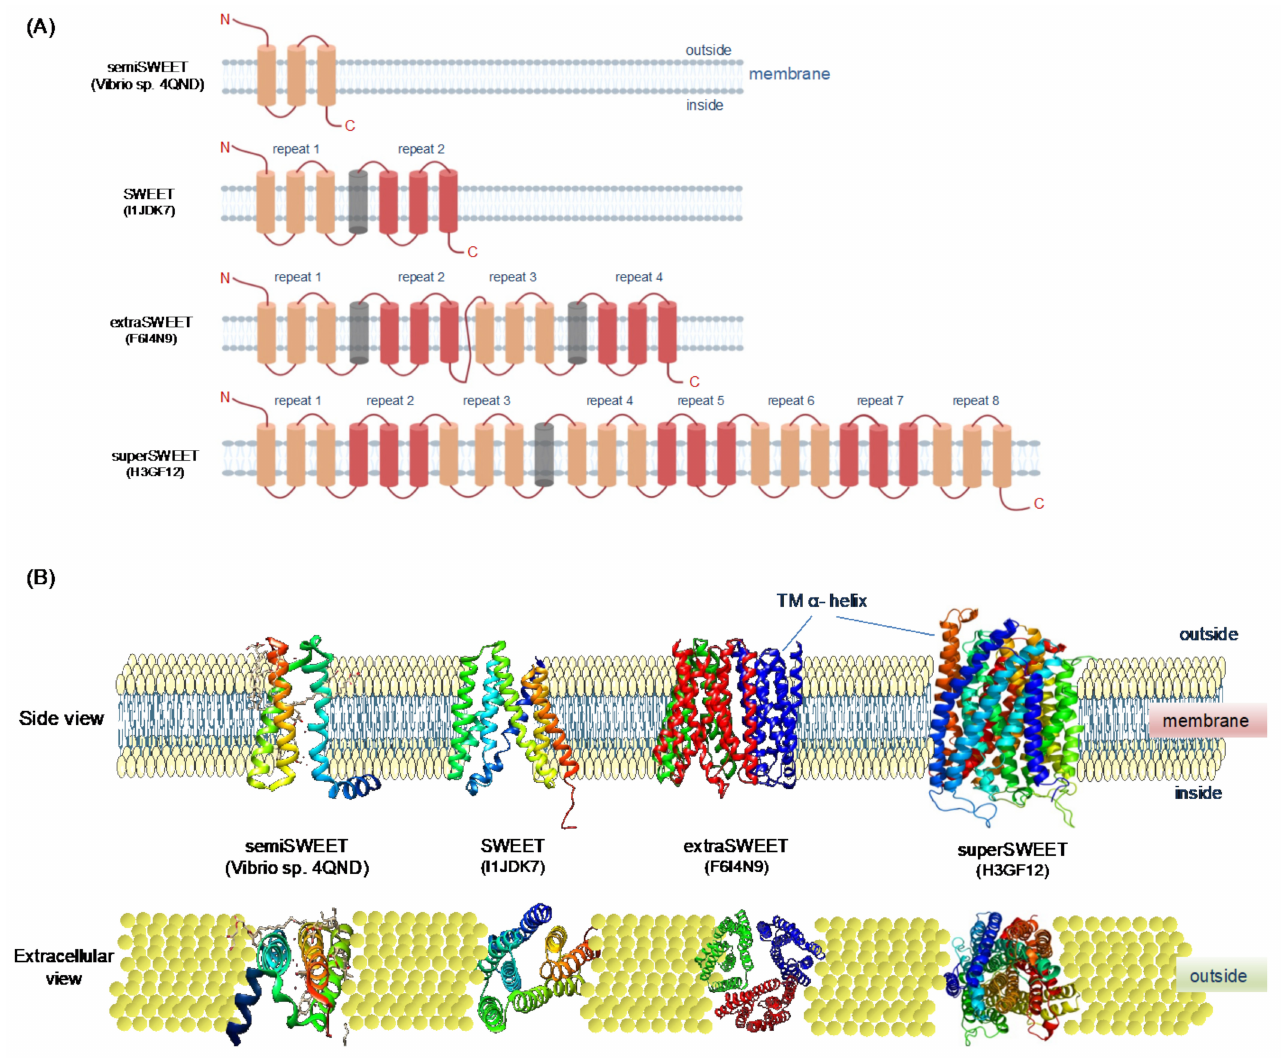
Figure 2. Schematic representation of two-dimensional (2D) model and 3D protein structures of four types of SWEET proteins based on 1, 2, 4 and 8, 3- transmembrane helices (TMH) domains. ( A ) Two-D models of semiSWEET, SWEET, extraSWEET and superSWEET proteins (their UniProt/PDB IDs are shown in the corresponding models). Colored boxes indicate TMHs, and loops are marked with lines. and triangles represent functional 3-TM units. ( B ) Side and extracel- lular view of three-D protein structures of four types of SWEET proteins. Images were prepared with